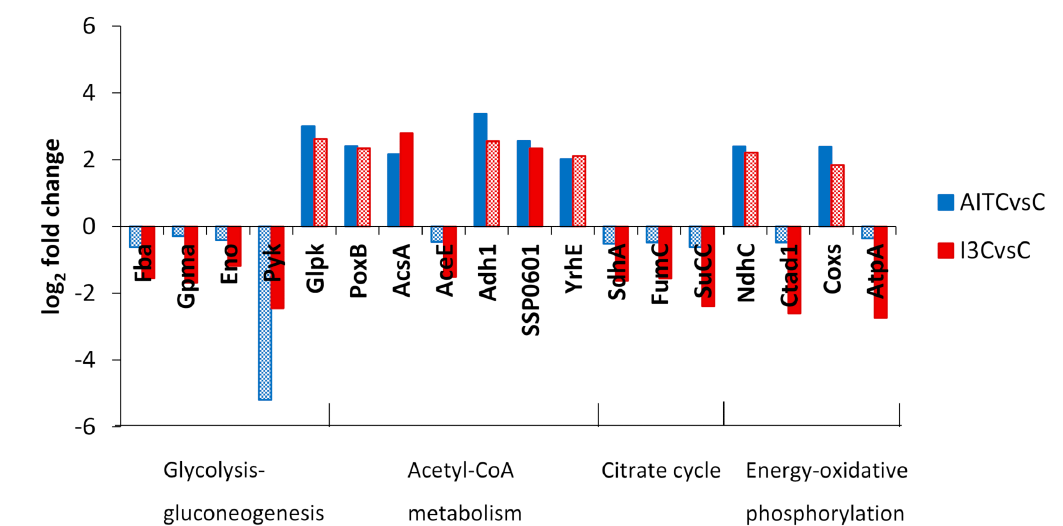
Figure 4. Log 2 fold change of DEGs classified into KEGG categories of glycolysis-gluconeogenesis, acetyl-CoA metabolism, citrate cycle and energy-oxidative phosphorylation in the comparisons AITC vs. the control and I3C vs. the control. Solid colours of the bars indicate a false discovery rate ≤ 0.05. A description of DEGs is provided in Supplementary Tables S1 and S2.